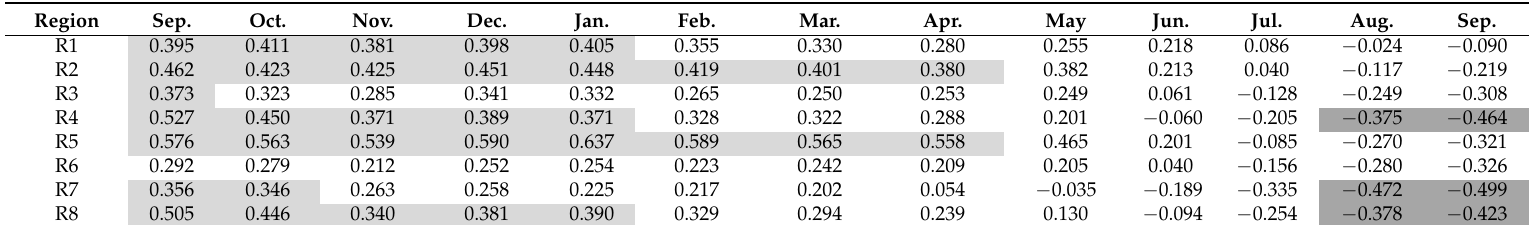
Table 6. Correlation coefficient values between the SWM rainfall and the MEI at various concurrent and leading months. Region Sep.